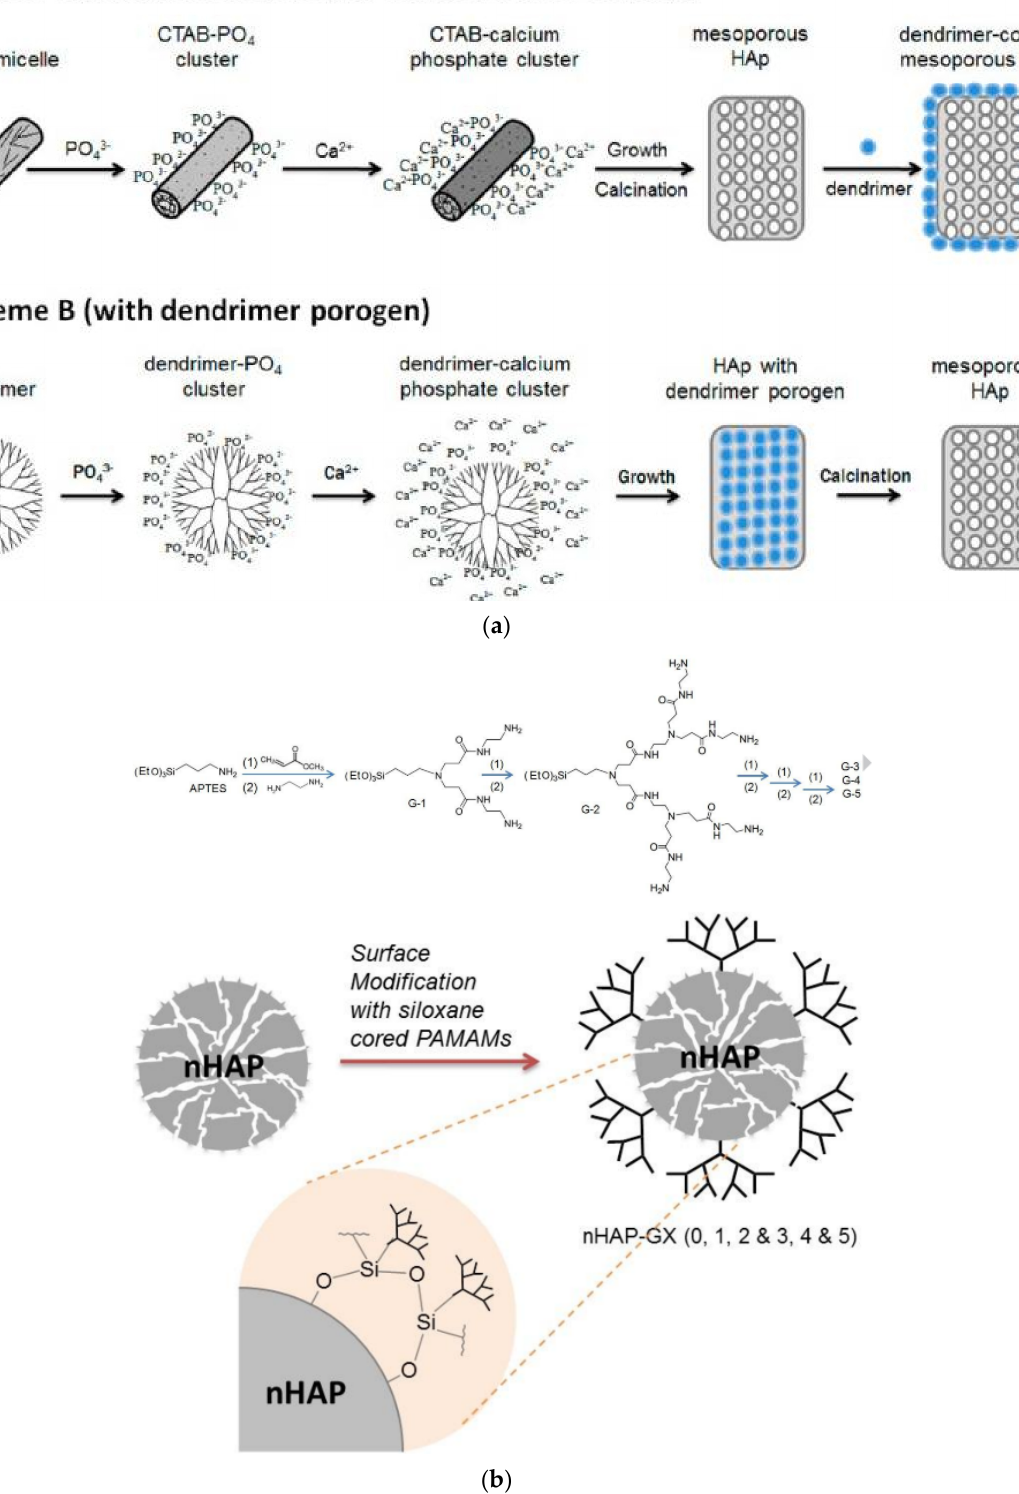
Figure 14. ( a ) Formation Process of Mesoporous HAp Powders Using Micelle and Dendrimer Poro- gens. Reproduced with permission from [172]. Copyright: American Chemical Society. ( b ) Synthetic path for the production of HAP functionalized by siloxane PAMAM dendrons Reproduced with permission from [173]. Copyright: Elsevier Inc.